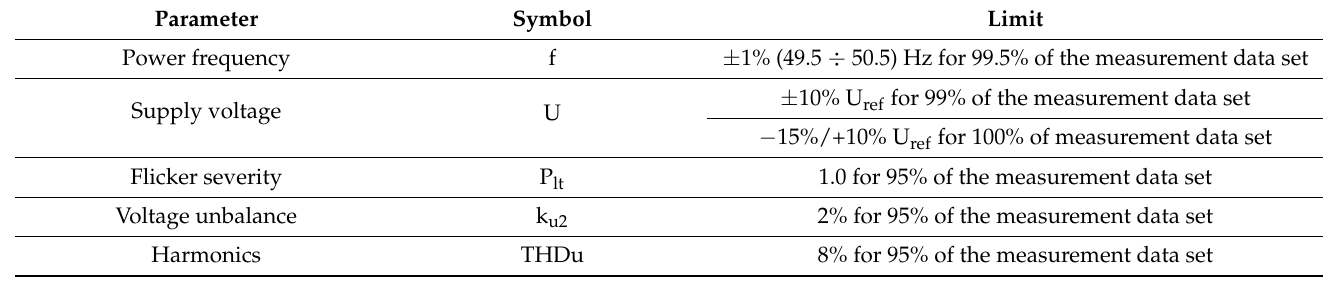
Table 1. Requirements regarding power quality in the low-voltage grid according to EN 50160 standard [66].